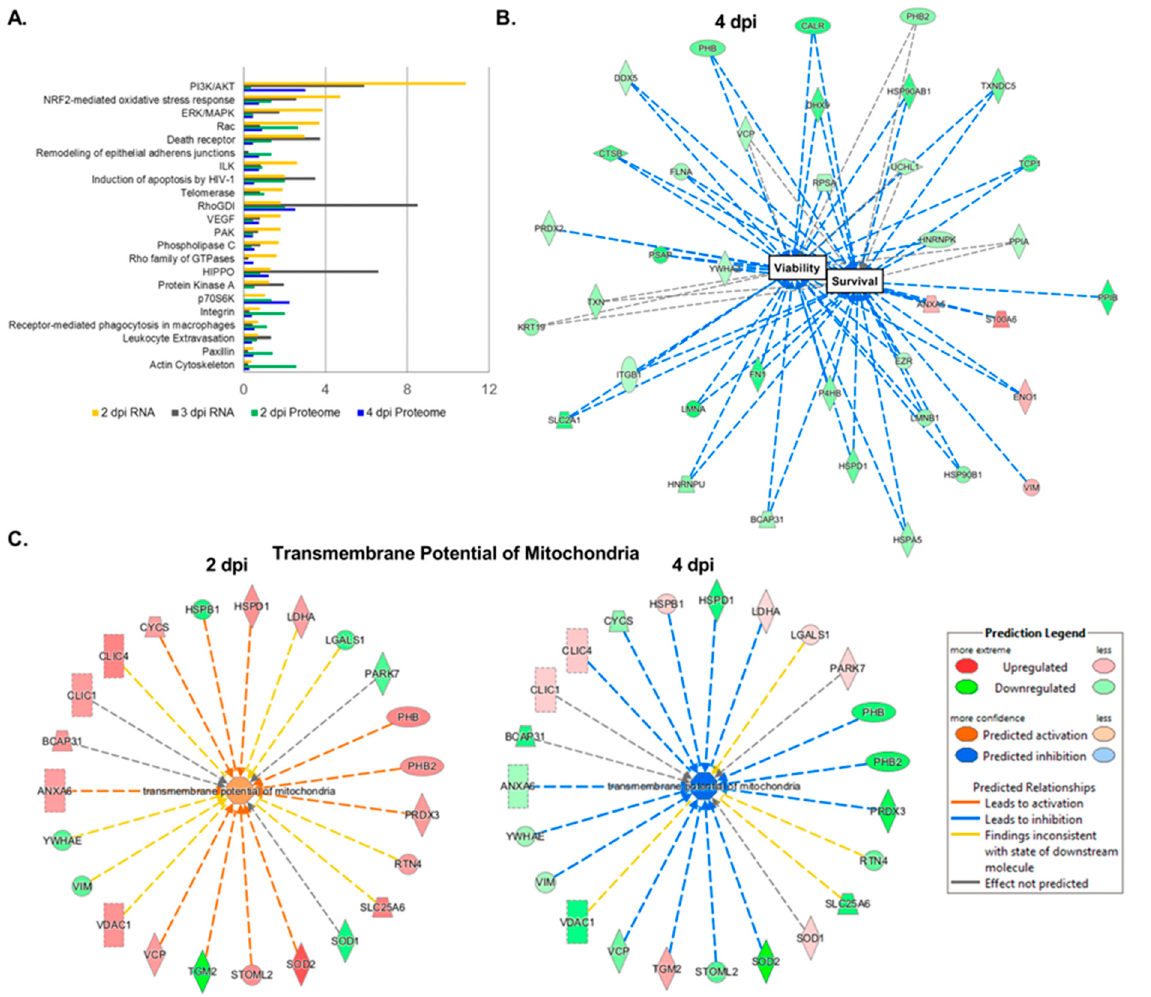
Figure 3. Proteomics analyses of human fetal RPE cells infected with ZIKV. ( A ) Graph shows key deregulated signaling pathways identified in ZIKV-infected FRPE cells through comprehensive proteomics and transcriptomics analyses. ( B , C ) Interaction networks of dysregulated factors involved in cell survival ( B ) and mitochondrial transmembrane potential ( C ) during ZIKV infection [upregulated (red); downregulated (green)]. For proteomics analyses, biological quadruplicates were performed and then samples were pooled in duplicate for mass spectrometry.